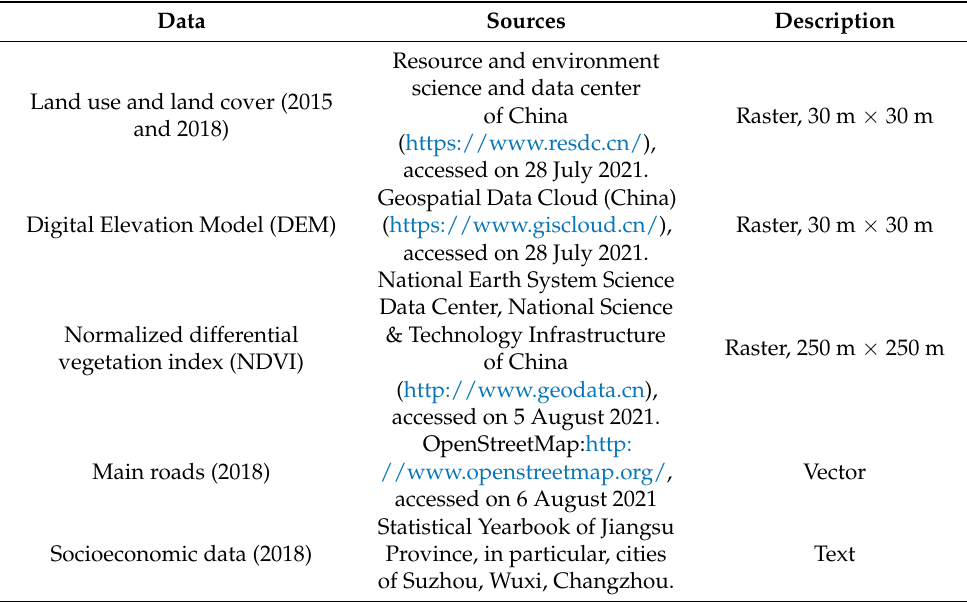
Table 1. The data and sources description. Data